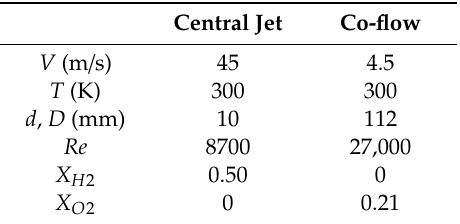
Table 1. Experimental conditions for non-reacting H 2 /N 2 jet [43] ( V : Velocity; T : Temperature; d , D : Diameters of central and annular jets; Re : Reynolds number; X i : Mole fractions).